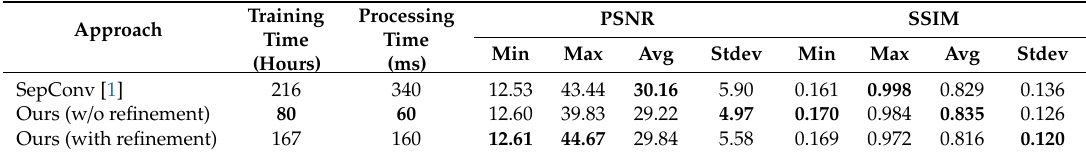
Figure 4. The average metric values, ( a ) PSNR and ( b ) SSIM, with respecting the processing time of various approaches, which include SepConv (black), the proposed approach without the refinement (blue), and the proposed approach with the refinement (green), to derive a 64-by-64-pixel output. Table 6. Comparisons of the proposed method and SepConv [44] on UCF101 1,2 . The best value of each column is in bold.